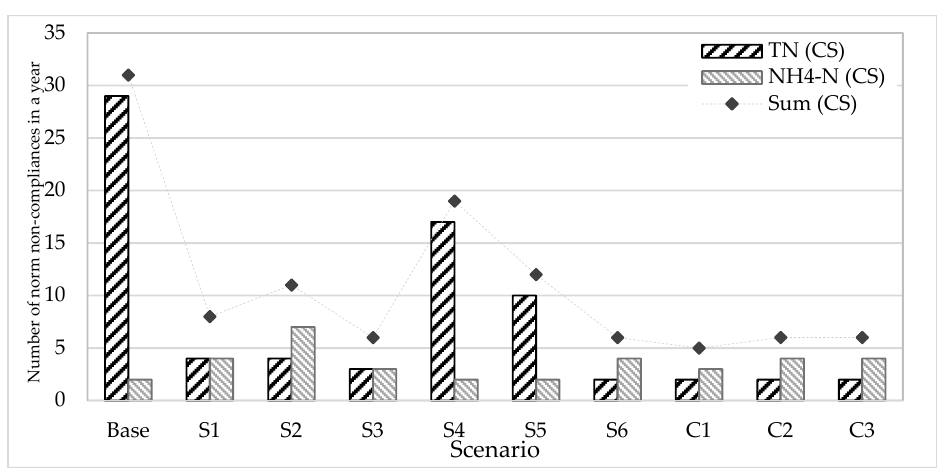
Figure 8. Number of norm non-compliances in a year with the CS norm.